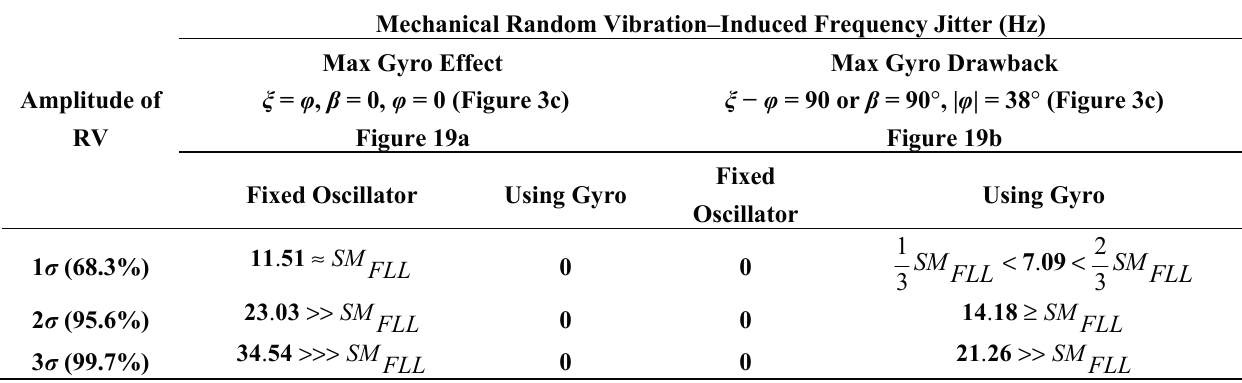
Table 3. Gyroscopic mounting effect on mechanical random vibration-induced disturbances on FLL. Mechanical Random Vibration–Induced Frequency Jitter (Hz) Amplitude of RV Fixed Oscillator Using Gyro